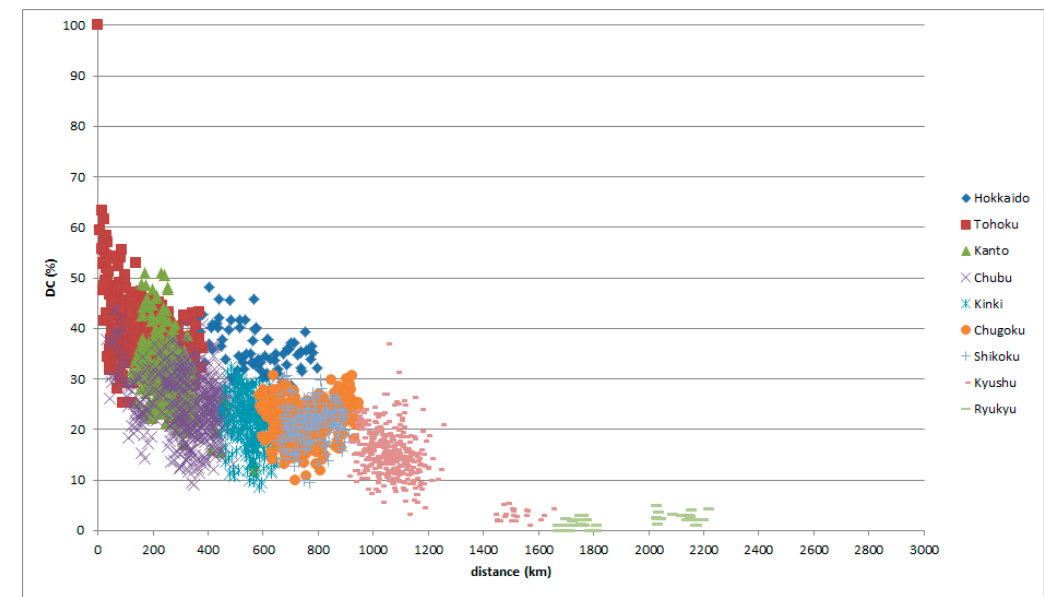
Figure 14. LAJ data with reference place in Tohoku, classified by comparison place.